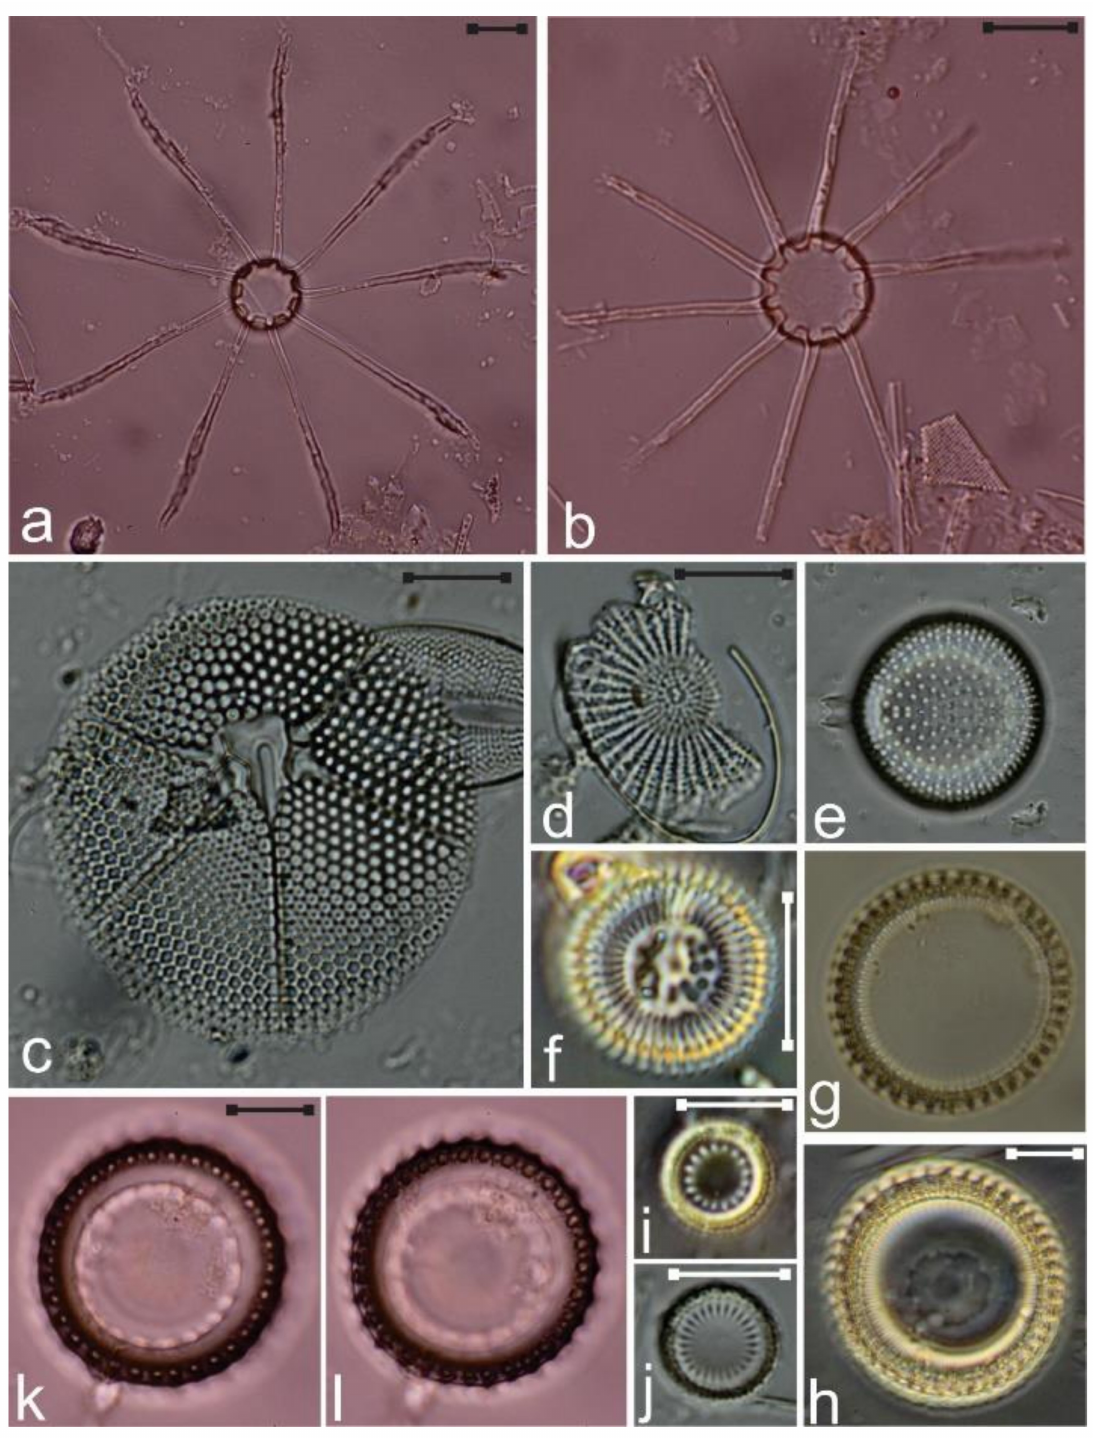
Figure 10. ( a , b ) Bacteriastrum hyalinum ; ( c ) Asteromphalus arachne ; ( d ) Cyclostephanos sp.; ( e ) Psammodiscus nitidus ; ( f ) Cyclotella striata ; ( g – l ) Paralia sulcata . Scale bar = 10 µ